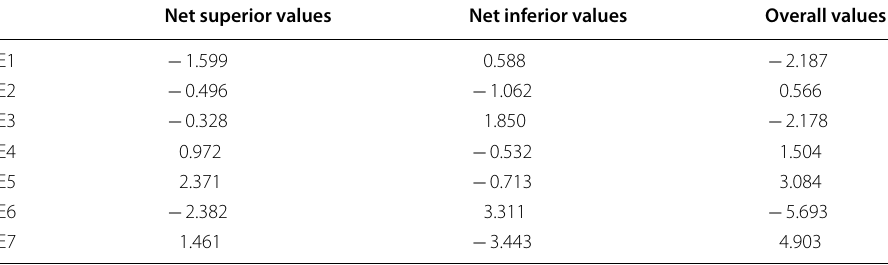
Table 25 Net superior, inferior, and overall values of the economies